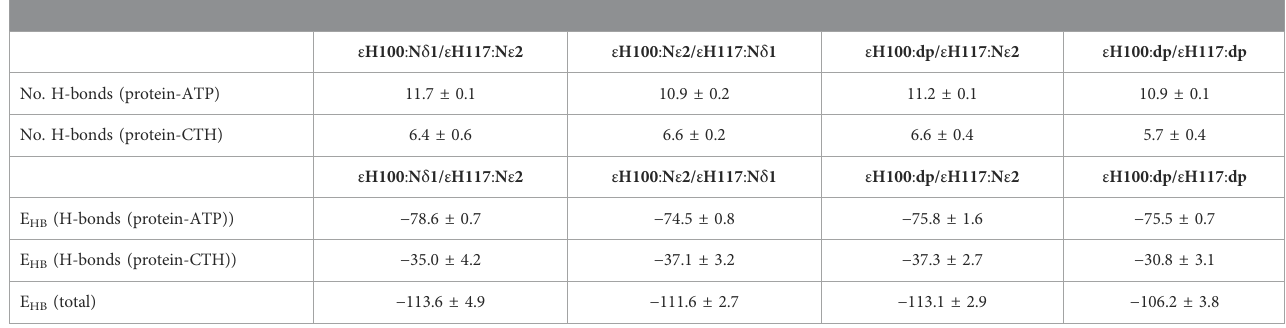
TABLE 1 Energetic analysis of ATP binding to the ε subunit. Number of hydrogen bonds (H-bonds) and energetics (E HB ) of ATP binding (enthalpic contribution) when the ε subunit from C. thermarum is simulated in different protonation states; the protonated imidazole nitrogen is indicated by N δ 1 (protonated at N δ 1), N ε 2 (protonated at N ε 2) or dp (double protonated). Interactions were measured between ATP and protein, as well as between the CTH and remainder of the protein; the totalenergyshownisasumofthesetwocontributions.Unitsofbinding energyarereported inkcal/mol.Data isanaverage of3replica100nssimulations